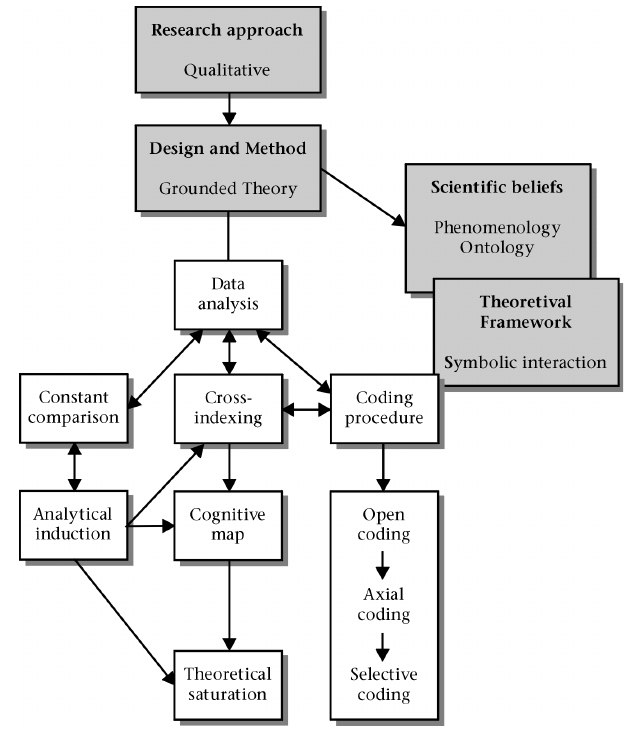
Figure 1: Summary of the research design and